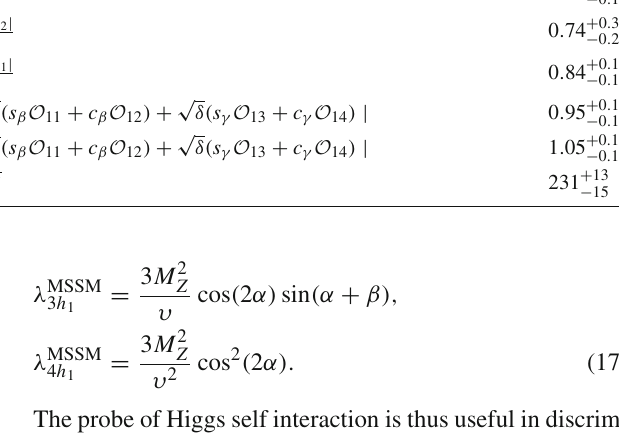
Table 2 LHC constraints from global fits to SM-like Higgs couplings [22] and weak scale υ [19] at 68% CL. Mass parameter is in unit of GeV